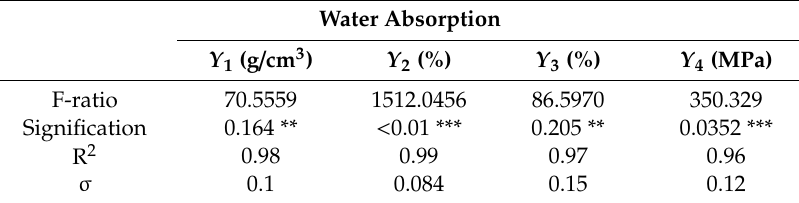
Table 3. Of variance (ANOVA), values of correlation coe ffi cient (R 2 ) and standard deviations ( σ ) for the considered responses: Y 1 : density; Y 2 : firing shrinkage; Y 3 : water absorption; Y 4 : bending strength.